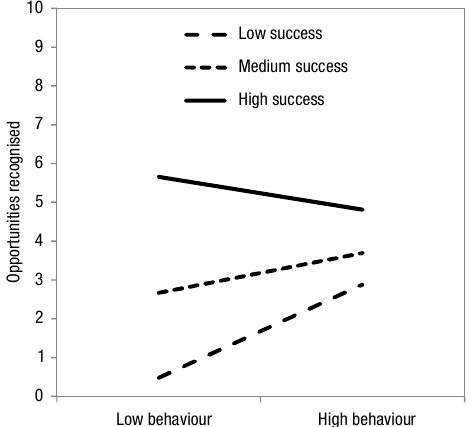
Fig. 1. Interaction effect of CE success and frequency of opportunities Table 3. Moderation effect of CE success on the relationship between frequency of opportunities recognised and opportunity recognition motivators Base model Including moderator B SE b B